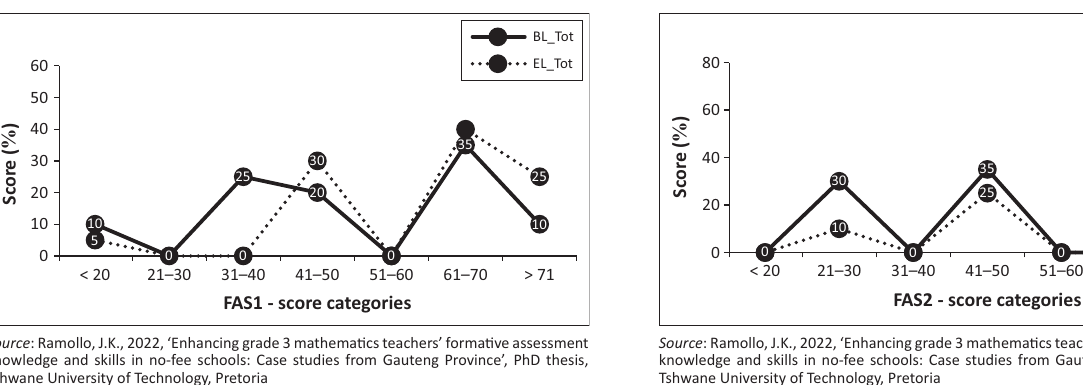
FIGURE 2: Formative assessment strategy 1 frequency score distribution. FIGURE 3: Formative assessment strategy 2 frequency score